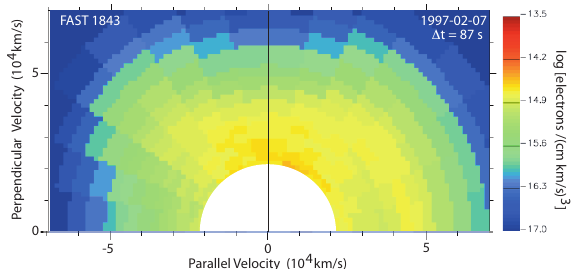
Fig. 6. A typical full ring-horseshoe distribution of electrons mea- sured within a time interval of 1t = 87s during FAST 1843. The low-energy electron background has been eliminated. The distribu- tion is plotted in v ⊥ ,v k space. The relative intensities are given by the colour bar on the right. One recognises the ring and the loss-